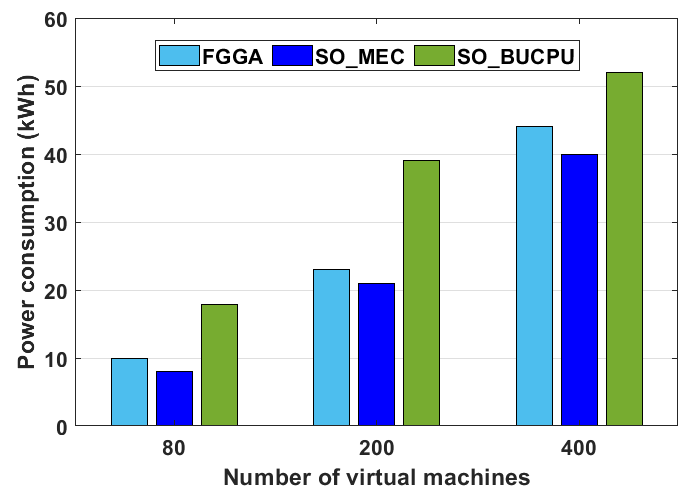
Figure 9. Comparison of power